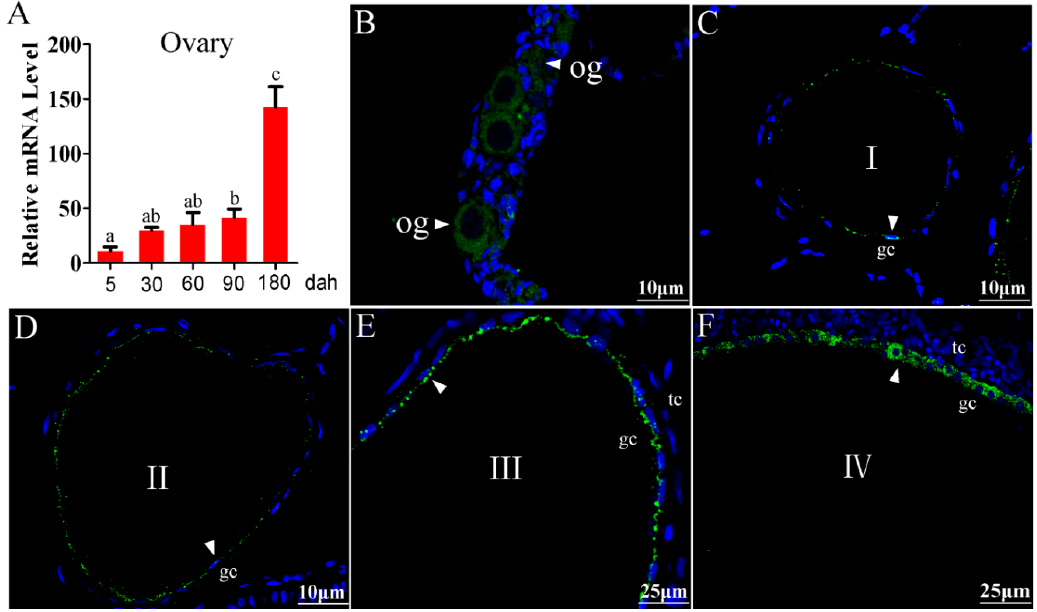
Figure 1. Immunofluorescence (IF) localization of Tsp1a in tilapia ovaries. ( A ) Expression of tsp1a mRNA in the tilapia ovaries at different developmental stages, as determined by qRT-PCR. Data are expressed as the mean ± SD of three different gonadal pools at each developmental stage. Different letters above the error bar indicate statistical differences at p < 0.05 as determined by one-way ANOVA followed by Tukey test. ( B – F ) Cellular localization of the Tsp1a protein in tilapia ovaries, as determined by IF. og, oogonia; I to IV, phase I to IV follicles; gc, granulosa cell; tc, theca cell. Green fluorescence represents the Tsp1a signal (white arrow). Blue fluorescence represents the DAPI signal. Tsp1a was expressed in the oogonia and granulosa cells of phase I to phase IV follicles.